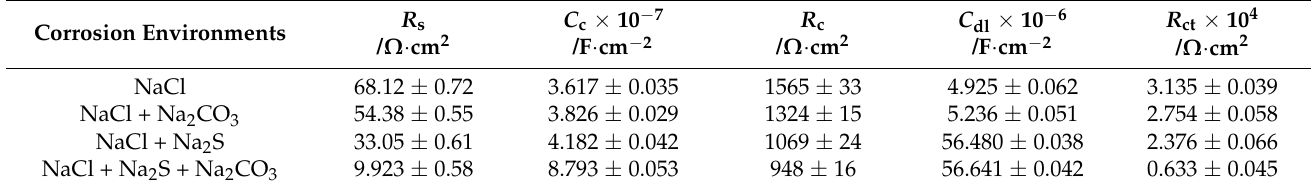
Table 6. Alternating-current fitting results of TC4 titanium alloy in various corrosion